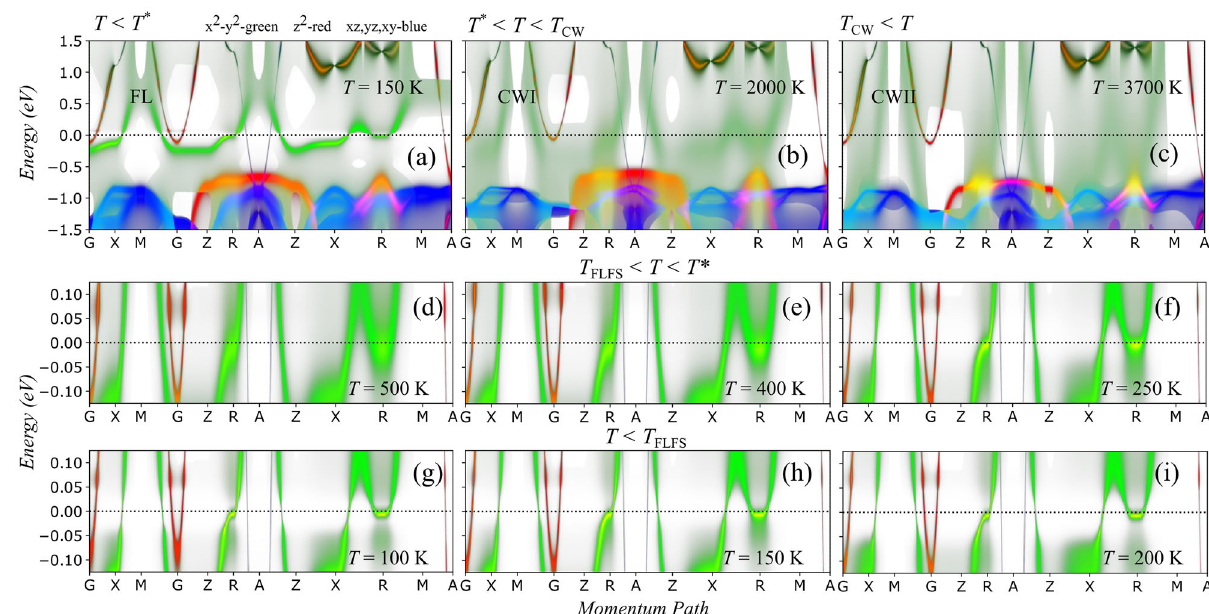
Fig. 2 Orbital projected spectral functions for LaNiO 2 ; U = 7 eV. a – c show the temperature ( T ) dependence of the spectral function while the other panels show the temperature ( T ) dependence of the spectral function around the Fermi level for T FLFS < T < T * ( d – f ), and for T < T FLFS ( g – i ). In the last set of panels, we can see explicitly the high degree of coherence of the states at the Fermi level. The orbital character corresponding to { z 2 }, { x 2 – y 2 } and { xz , yz , xy } is given by red (R), green (G), and blue (B), respectively; any other color in the plots obtained from a RGB combination corresponds to orbital mixing of the { z 2 }, { x 2 – y 2 } and { xz , yz , xy